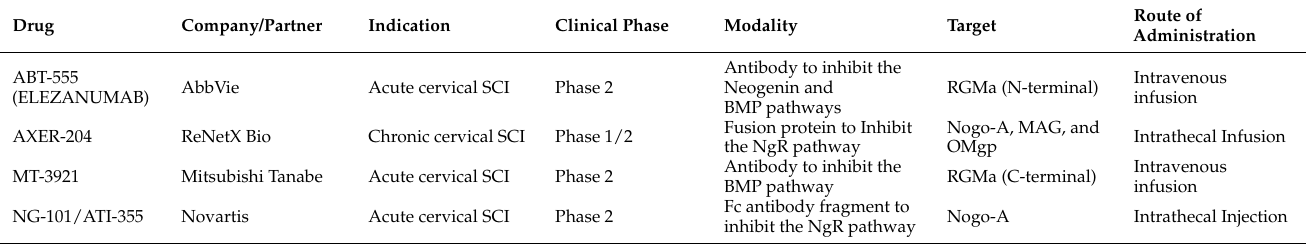
Table 6. SCI benchmarking results: preferred routes of administration for the treatment of